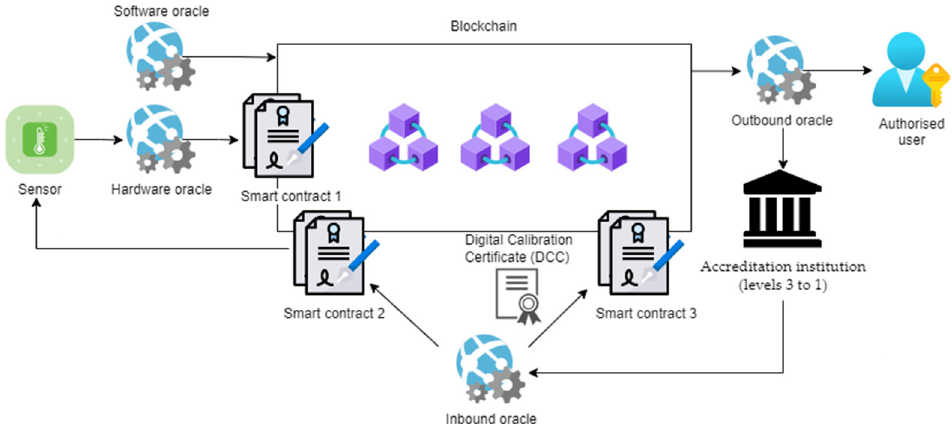
Figure 5. Concept of complete trust hierarchy. Table 2. Normative standards and legal requirements according to [44].